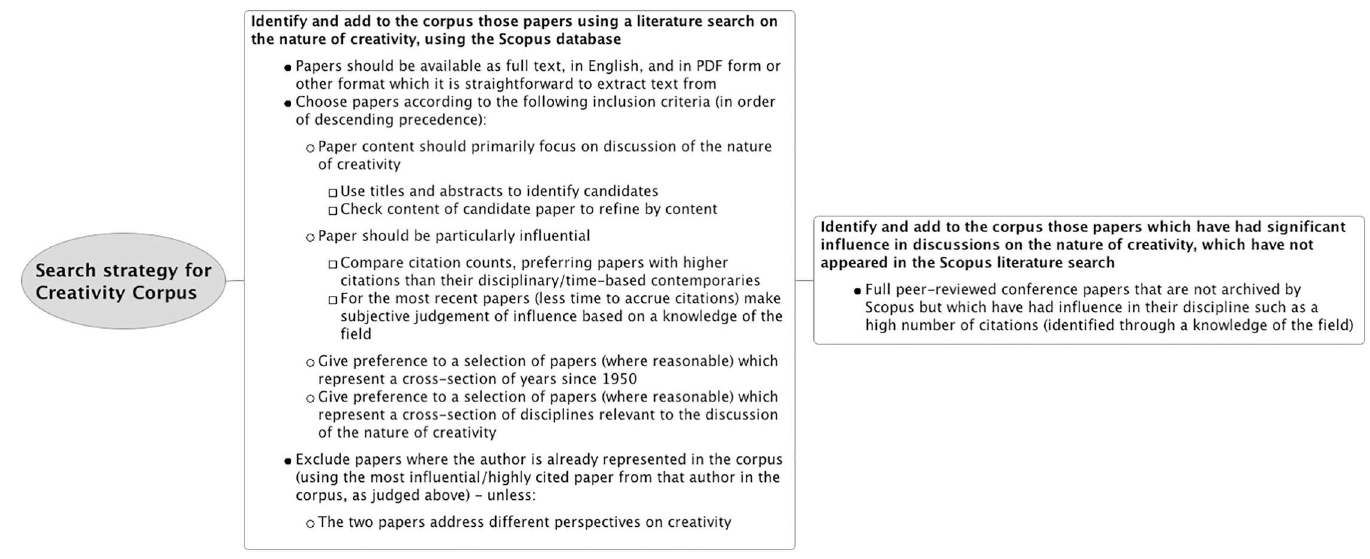
Fig 1. A flow diagram describing the search strategy used to identify papers for the creativity